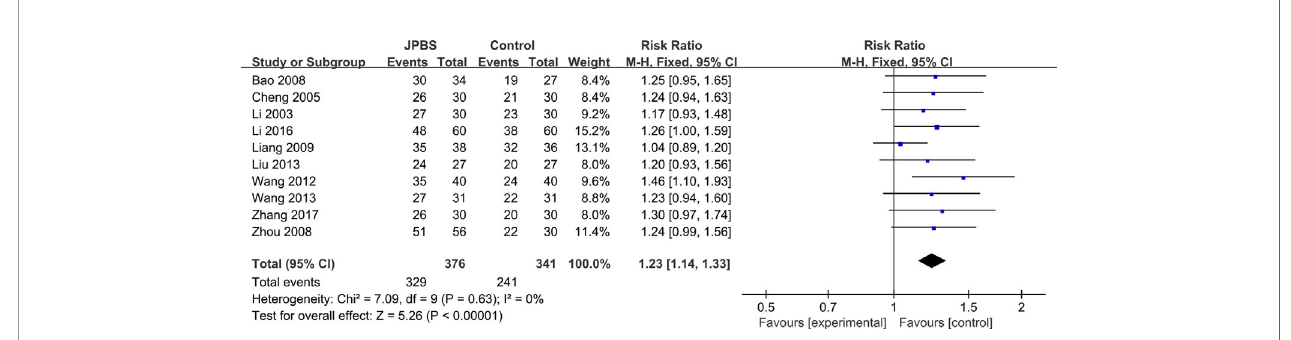
FIGURE 4 | Forest plot of clinical ef fi cacy